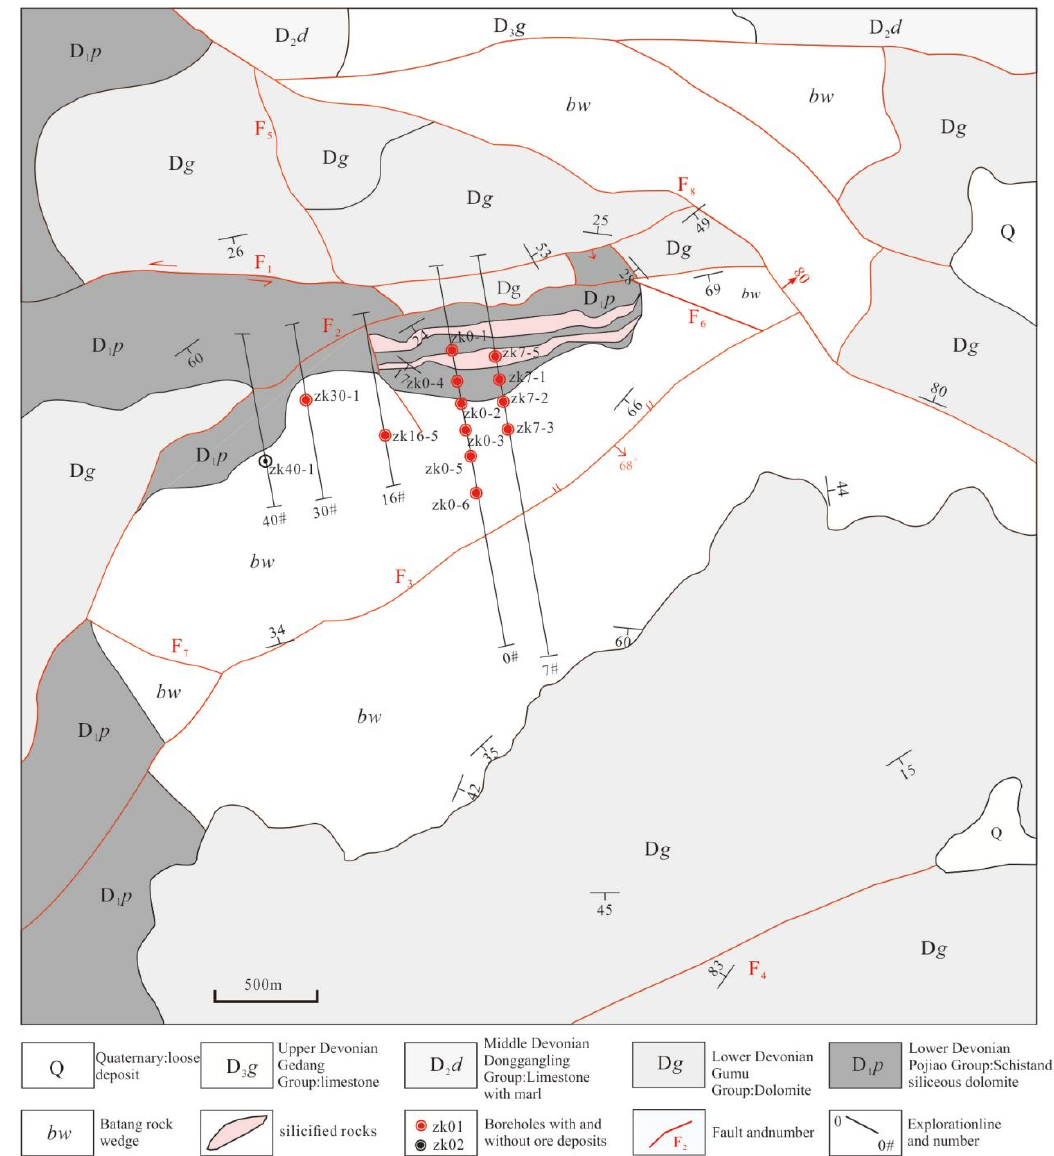
Figure 1. Geotectonic location map of the study area ( a , modified according to [9]) and the regional geological map ( b , quoted from [10]).